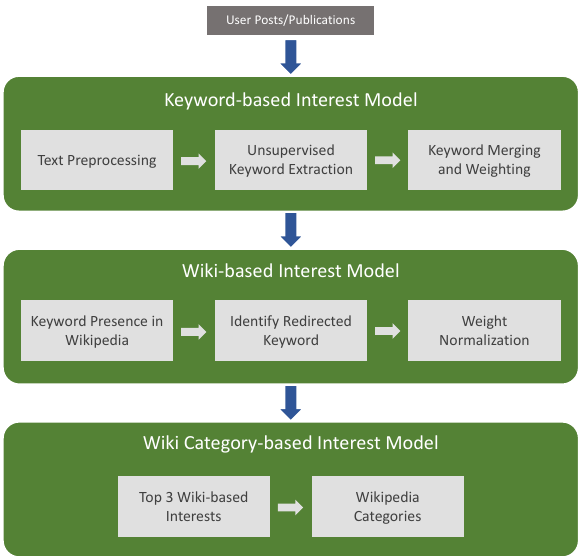
Figure 2. Interest model generation in RIMA